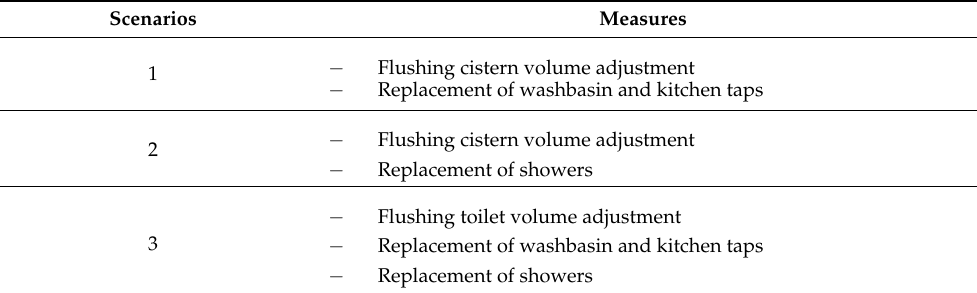
Table 2. Proposed scenarios for reducing water expenditure in the Bragança municipal swimming pool complex.